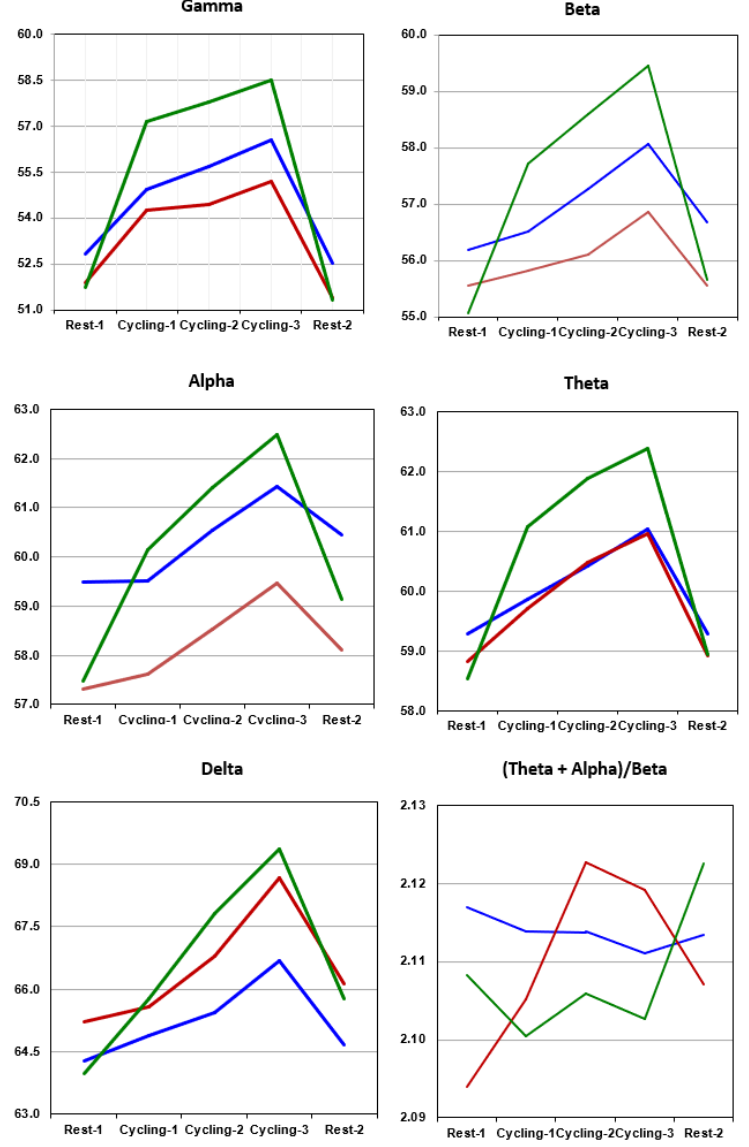
Figure 3 . Oscillatory activity in different frequency bands, as observed in the central electrodes (C3, C4 and Cz) under resting-states and during cycling exercise ( blue = Class 1, red = Class 2 and green = Class 3). At the bottom of the right panel, the ratio between theta plus alpha and beta powers are depitcted for the 3 classes.